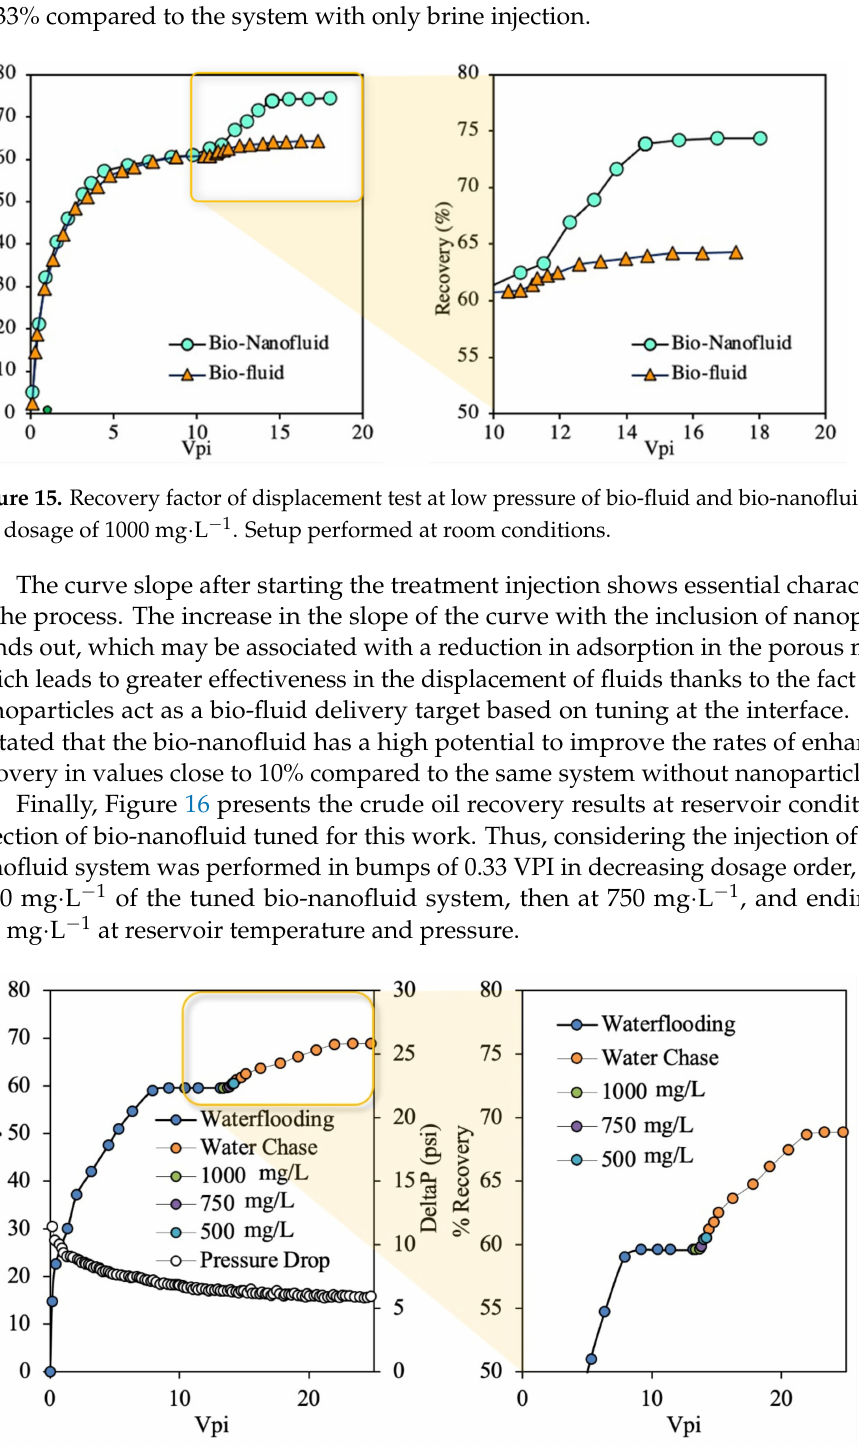
Figure 16. Recovery factor of displacement test at reservoir conditions of bio-nanofluid tuned with SiO 2 -RH nanoparticles at 100 mg · L − 1 assessed in dosage of 500, 750, and 1000 mg · L − 1 at 0.33 VPI each one before waterflooding. Setup performed at reservoir conditions (overburden pressure 2500 psi and 47 ◦